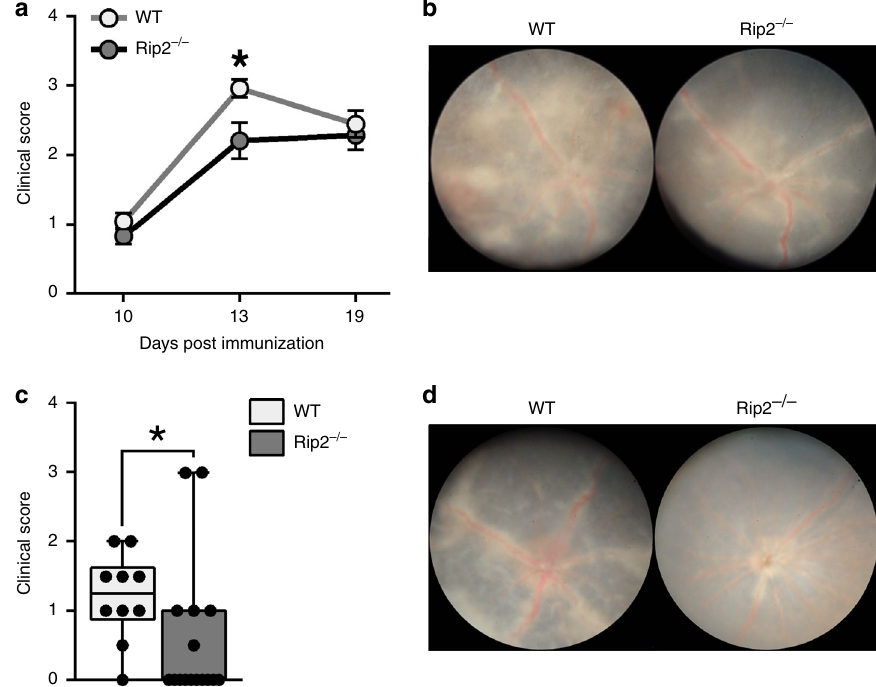
Fig. 6 Nod2 functions independent of Rip2-signaling in T cells. a – b EAU was induced in WT and Rip2 − / − mice. Data are combined from 3 independent experiments. For WT, n = 10 (10 and 19 day) and 24 (13 day). For Rip2 − / − , n = 9 (10 day), 21 (13 day), 12 (19 day). a Clinical uveitis was evaluated weekly by fundoscopy; * p = 0.0320. b Representative fundus photographs 13 days post-immunization. c – d Rag1 − / − mice were reconstituted with thymocytes from naïve WT or Rip2 − / − mice and immunized with IRBP 8 days later. Data are combined from 2 independent experiments with n = 10 (WT recipients) and n = 18 (Rip2 − / − recipients). c Clinical uveitis was evaluated by fundoscopy 28 days post-immunization; * p = 0.0074. d Representative fundus photographs are shown. Data are mean ± SEM ( a ) or box-whisker plots showing median, 25 – 75th percentile, and min – max range (with dots representing individual values) ( c ). Statistical differences between groups were calculated using two-tailed Mann – Whitney U test ( a , c ). Source data are provided as a Source Data fi